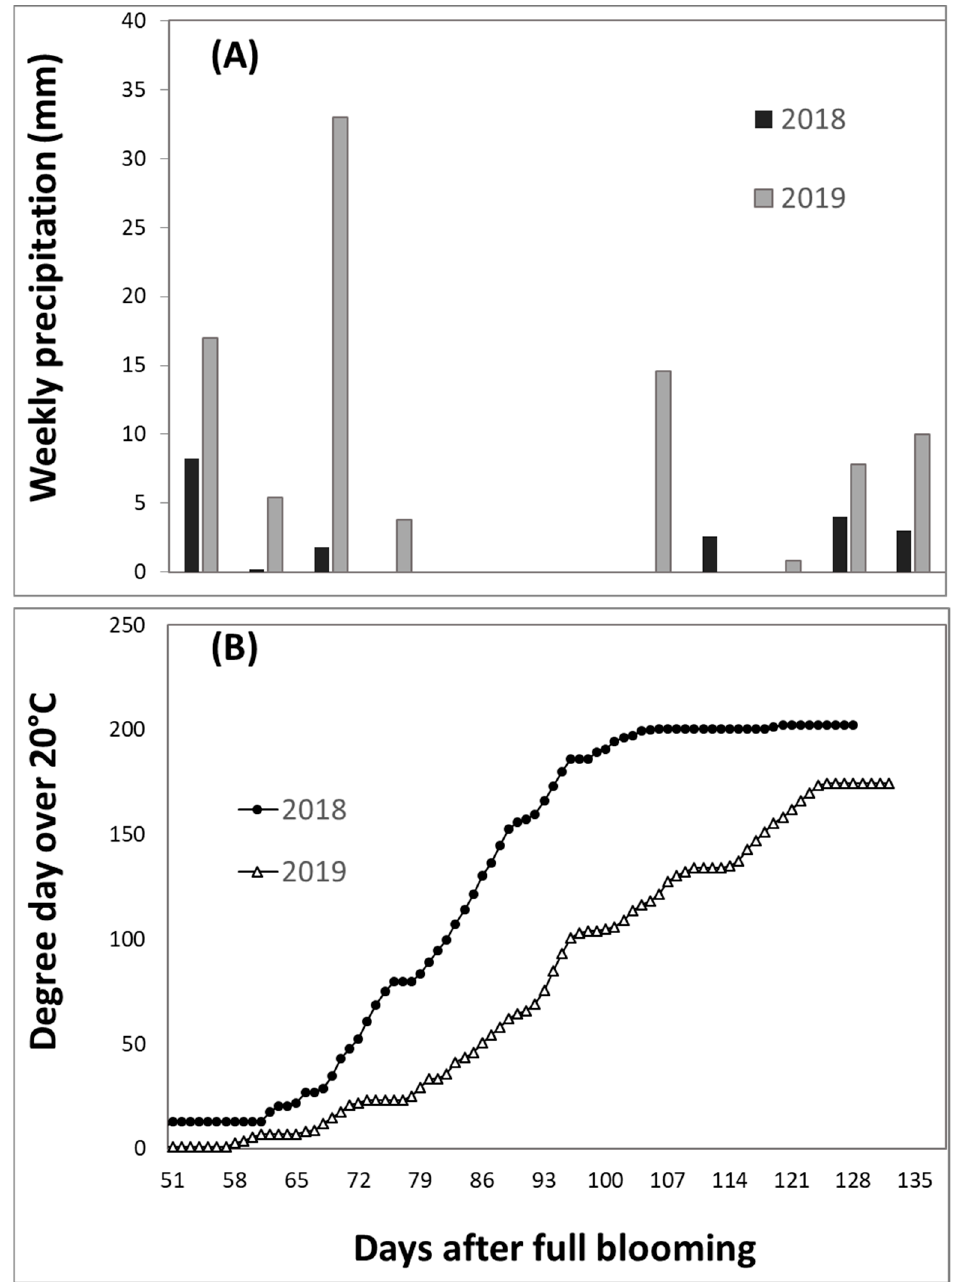
Figure 1. Weekly precipitation ( A ) and accumulated degree days above 20 °C that were calculated from the daily mean temperature ( B ) from early summer to harvest in 2 years in Cawston, BC (data obtained for Cawston, BC at Farmwest Historical Weather data site https://farmwest.com/climate/calculators, accessed on 13 May 2021).